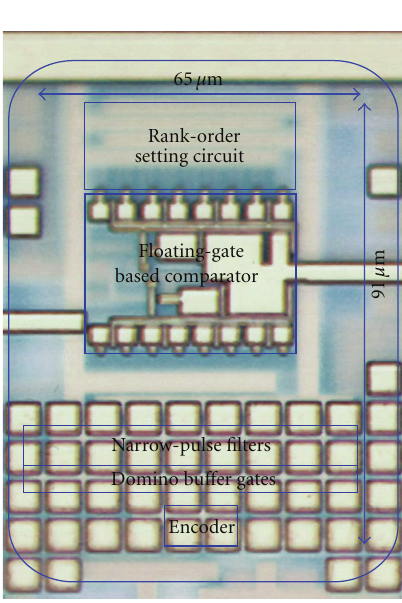
F 6: Photomicrograph of the roof-of-concept